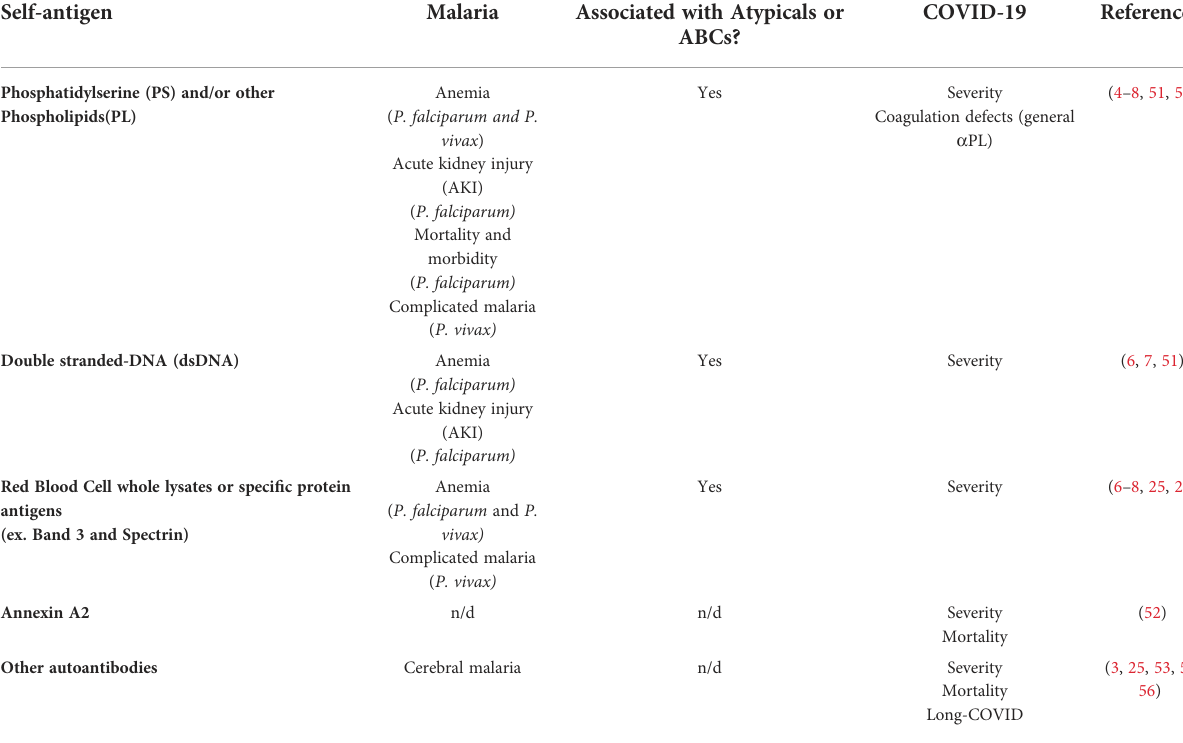
TABLE 1 Autoantigen targets for autoantibodies and their associated pathology during malaria or COVID-19. n/d, not determined. Self-antigen